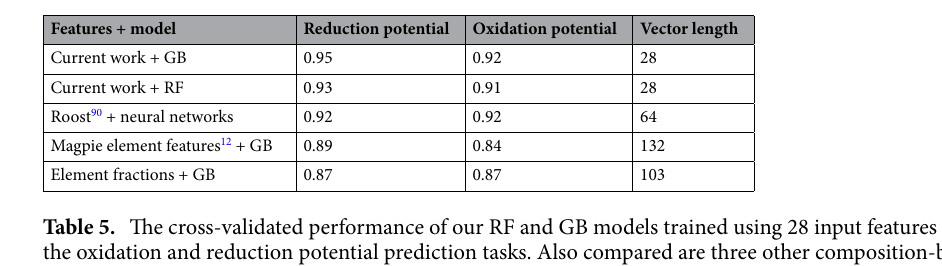
Figure 3. Permutation feature importance plot for the 3D barrier GB model showing the decrease in R upon random permutation of individual feature vectors. Higher values indicate a larger impact on predictions. Only features with the top 10 PFI scores are shown.